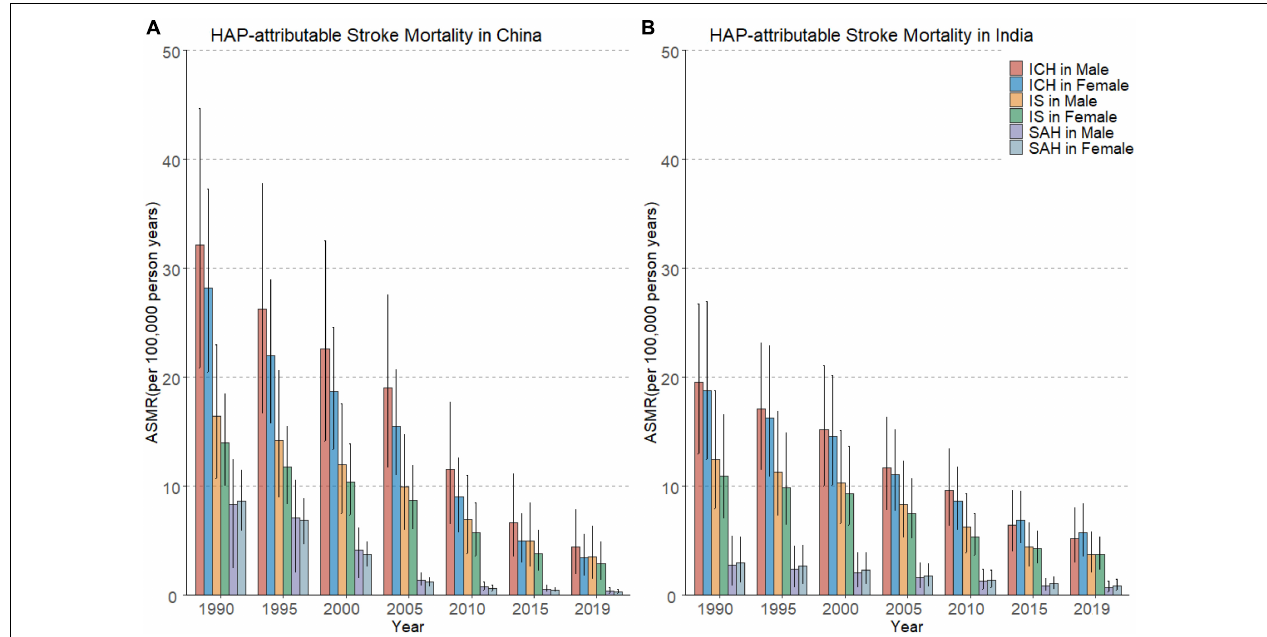
FIGURE 1 | Trends in the age-standardized mortality rates (ASMRs) of household air pollution (HAP)-attributable stroke subtypes in China (A) and India (B) from 1990 to 2019. Error bars represented the 95% CIs for the HAP-attributable stroke mortality.